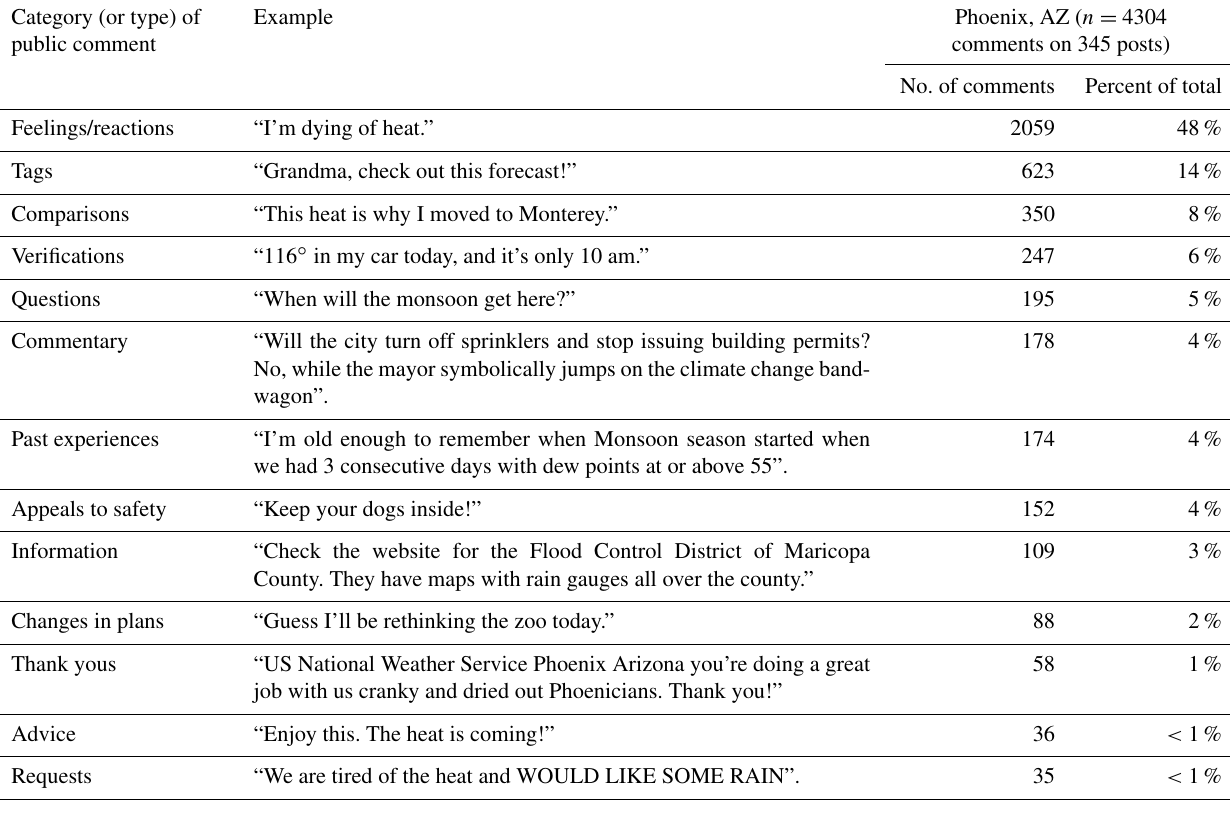
Table 1. Summary of public comment categories (or types) (US National Weather Service Phoenix Arizona, 2021). Category (or type) of